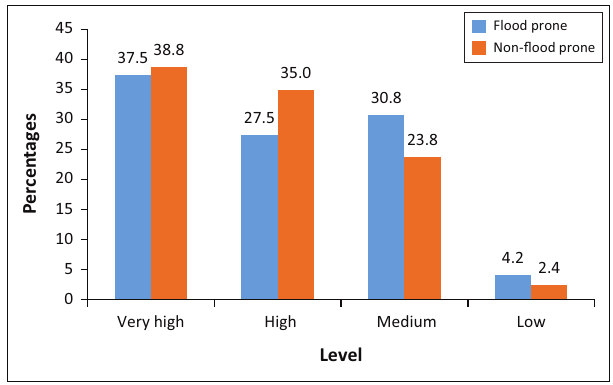
FIGURE 2: Level of awareness of flood disaster risks among residents of Asamankese.